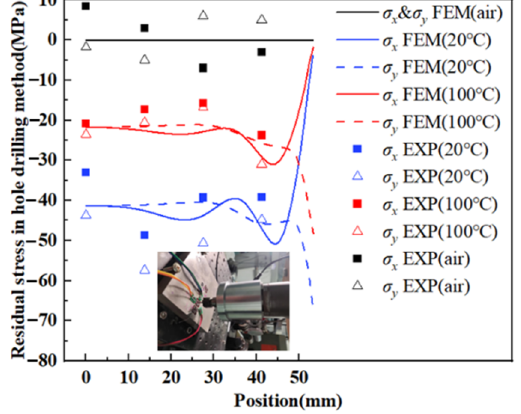
Figure 10. Simulation and experimental results of RS in hole drilling method along path AB.